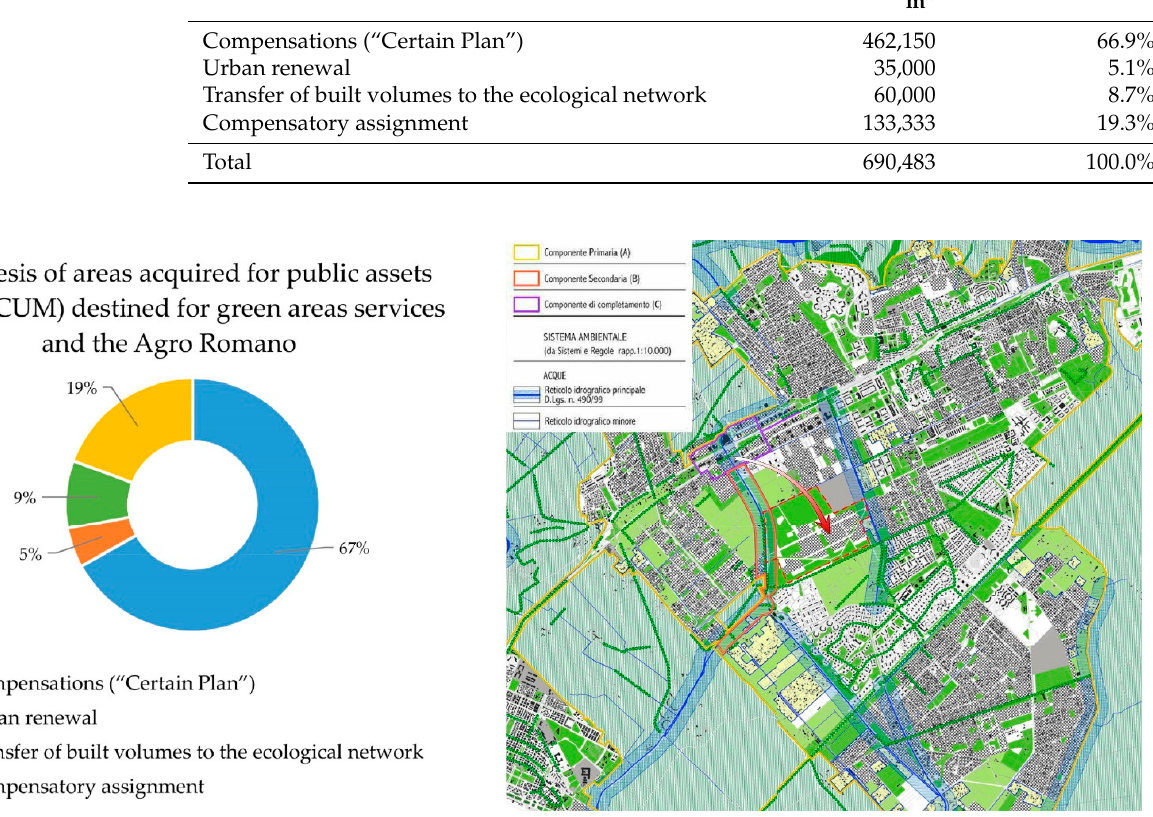
Figure 14. Left. Hypothesis of areas acquired for public assets (outside CUM) destined for green areas services and the Agro Romano (Source: elaborations by the author). Right. Transfer of built volumes to the ecological network. (Source: elaborations by the author; P4. Ecological network: